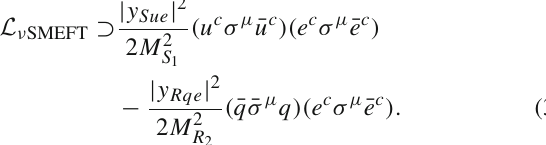
at | D | ≈ 2 × 10 − 6 in the allowed parameter space. The gray-shaded area (Direct) is excluded by the LHC searches for leptoquark pair pro- duction. For these Yukawa couplings pp → e + e − gives almost the same exclusion limit, although for such moderate values of M the EFT analysis we perform is not a very good approximation of the Drell–Yan process in the full leptoquark model and it overestimates the bounds somewhat. The orange-shaded are shows the EDM constraints, which are again